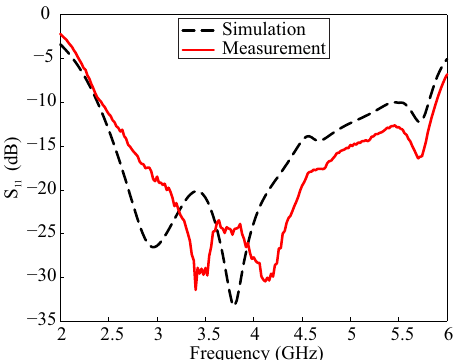
Figure 7. Simulated and measured reflection coefficients of the proposed antenna.